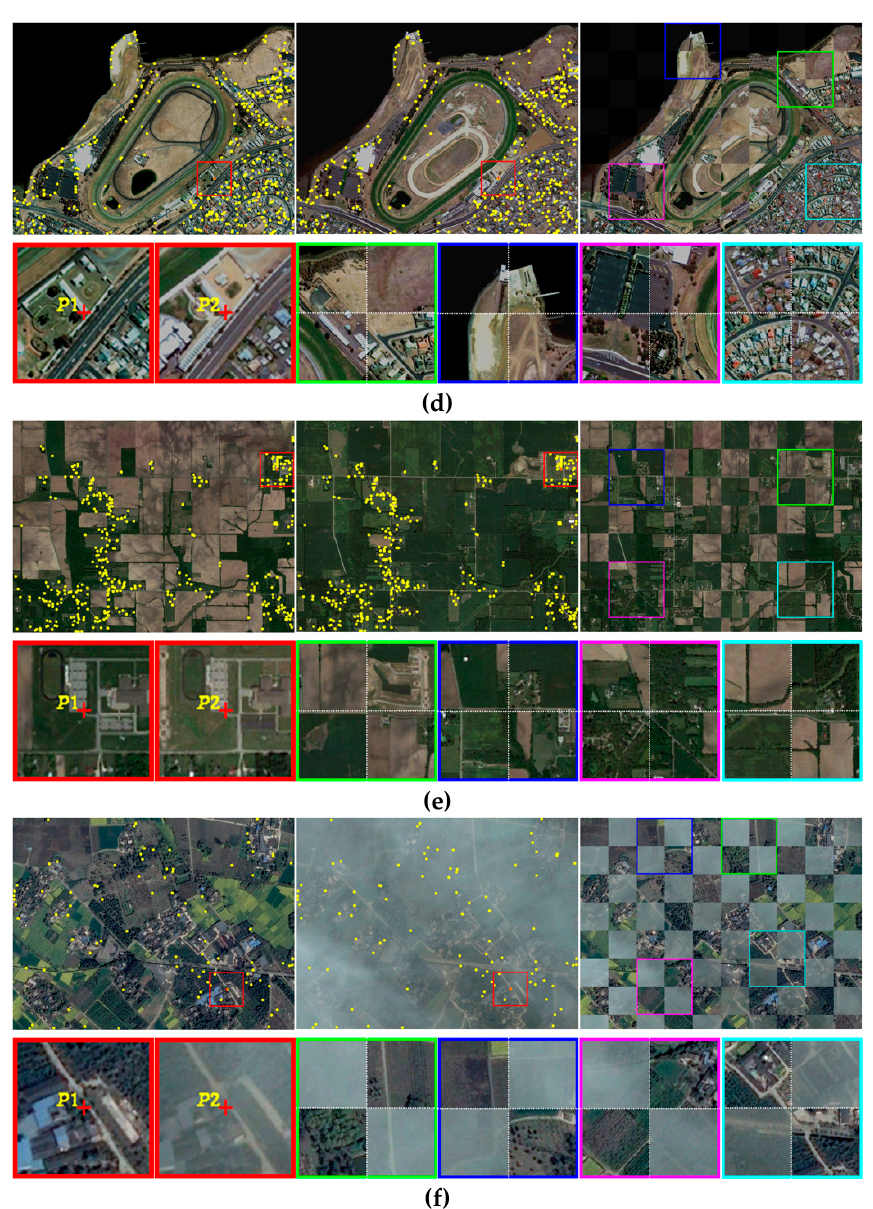
Figure 13. Matching and registration results of the proposed matching framework. The matches of Pairs 1–6 are pinned to the top-left two images of ( a – f ) using yellow dots. The two small sub-regions marked by red boxes correspond to the two conjugated patches P1 and P2. The top-right image shows the registration result of the checkerboard overlay of the image pair. The four small sub-regions marked by green, blue, magenta, and cyan are enlarged to show the registration details.